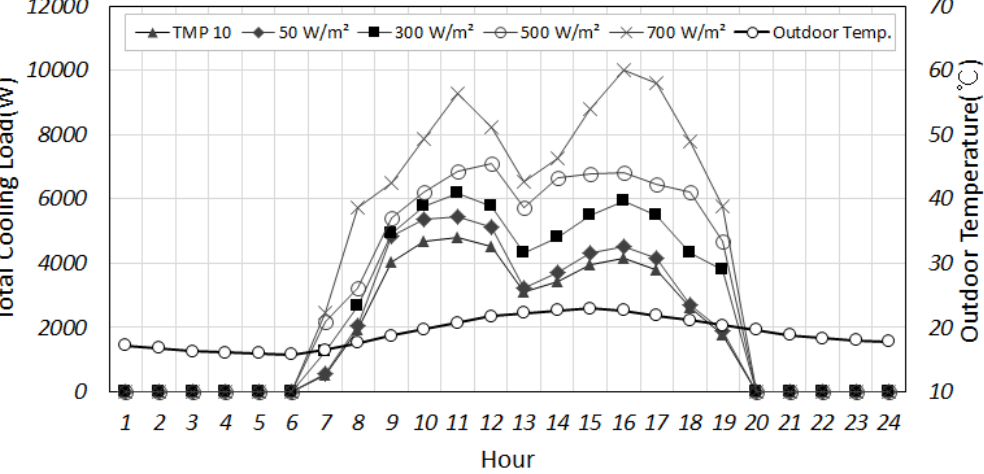
Figure 8. Cooling load of electrochromic glass on a typical summer day by controlling conditions.